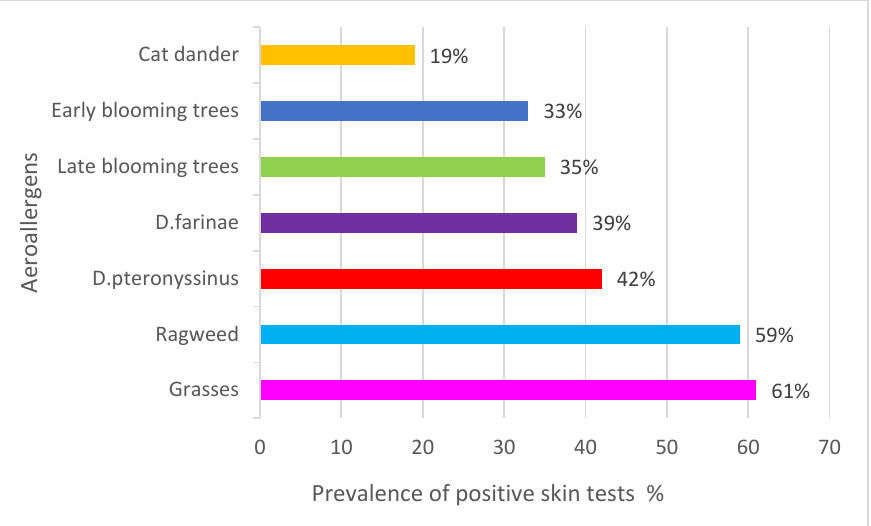
Figure 5. Allergic sensitisation profile obtained by SPTs in the group of 7 – 14-year-old children, 2018. In comparison with the year 2002, the allergen sensitivity rate was similar, while the atopy profile was slightly different, with grasses being a dominant sensitiser.